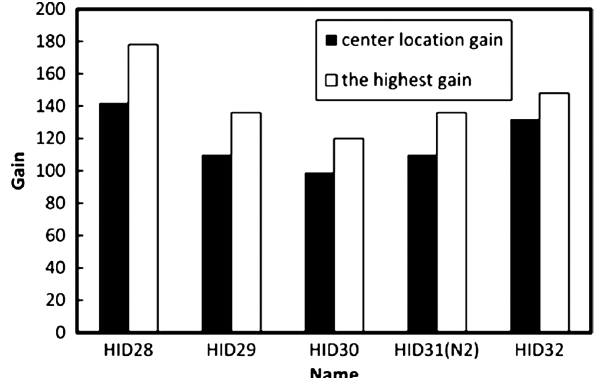
FIG. 5. The gain in five different diamond amplifiers. HID 31 was transferred in dry N 2 protection from the hydrogenation system to the gain test system. The black columns show the gain of the centers of the diamond amplifiers, and the white columns show the maximum gain on the